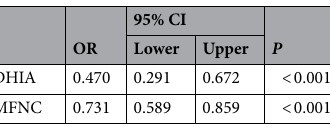
Table 6. Logistic regression. CI Confidence interval.